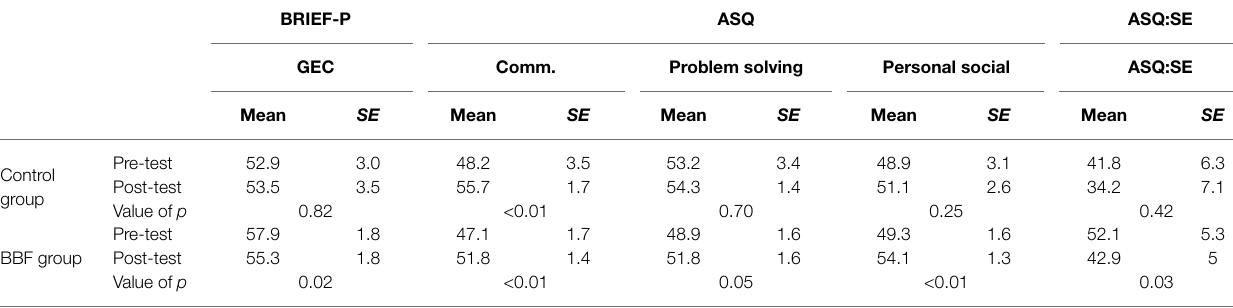
TABLE 1 | The statistics for the questionnaires. BRIEF-P ASQ ASQ:SE GEC